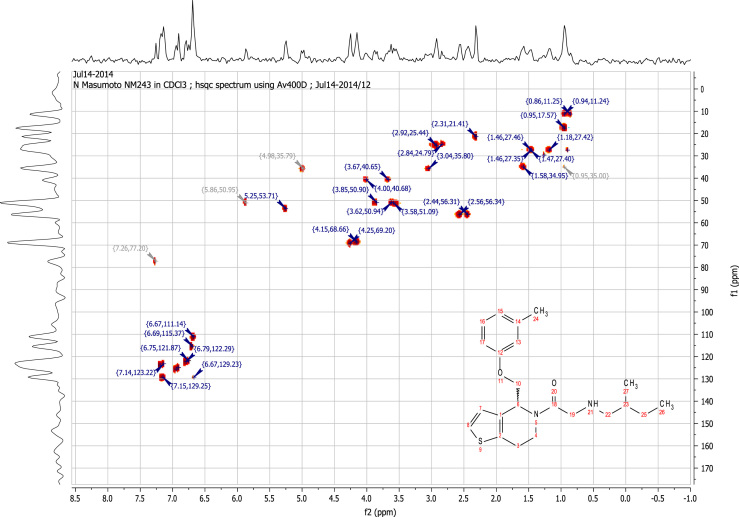
2D HSQC NMR (400 MHz,
CDCl3) of RU-SKI 43
(9b).